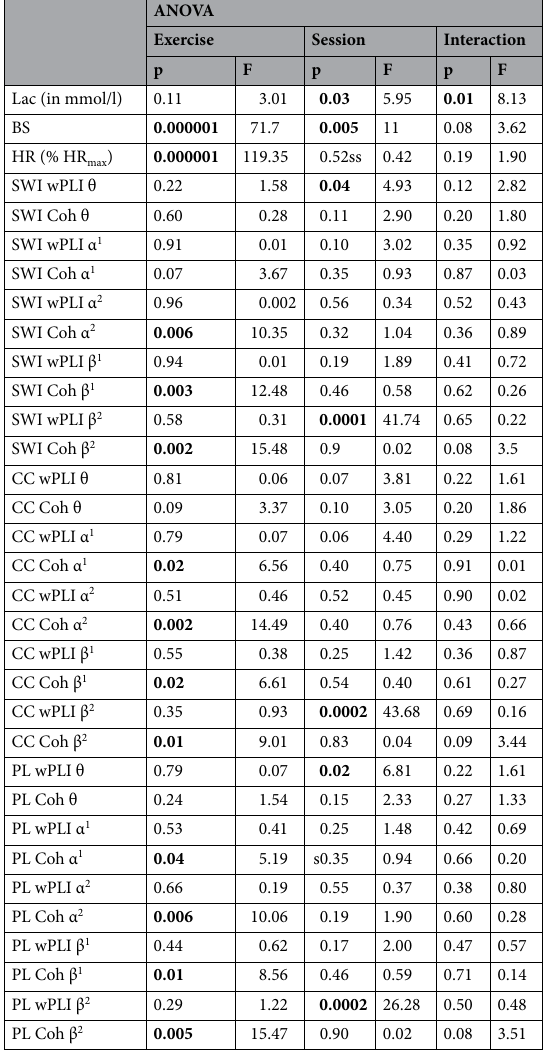
Table 2. Overview of ANOVA results for physiological and EEG outcomes before and after 10 min of running on the treadmill. The table presents p- and F-values of repeated measures ANOVA with the factors Exercise (PRE vs. POST) and Session (Session I vs. Session II) as well as analyses for Interaction effects. Significant effects (p < 0.05) are marked as bold. Significant effects are marked as bold. Blood lactate values (Lac) obtained from the right earlobe and Borg Scale (BS) were assessed before (PRE) and immediately after (POST) running on the treadmill. Average resting heart rate (HR rest ) is determined as the 5-min average heart rate recorded during the EEG resting state measurements performed in a sitting position. Small-World-Index (SWI), clustering coefficient (CC) and characteristic path length (PL) derived from Coherence (Coh) respectively weighted phase-lag-index (wPLI) are based on 5-min resting state EEG. SWI measures are presented for theta (θ, 4–8 Hz), alpha-1 (α 1 , 8–10.5 Hz), alpha-2 (α 2 , 10.5–13 Hz), beta-1 (β 1 , 13–20 Hz) and beta-2 (β 2 , 20–30 Hz) frequency